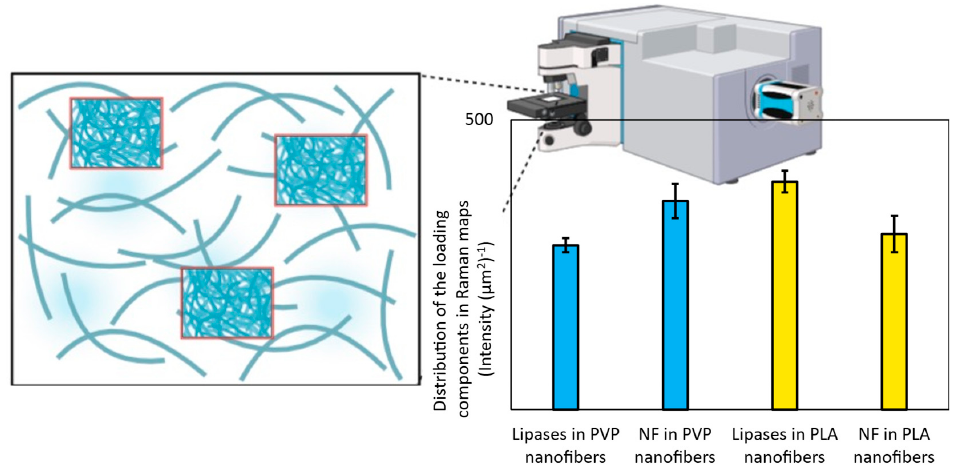
Figure 5. Distribution of lipases (RmL and CrL) and nadifloxacin (NF) in PVP and PLA nanofibers indicating the strong existence of enzymes or antibiotic agent based on their specific Raman intensity.